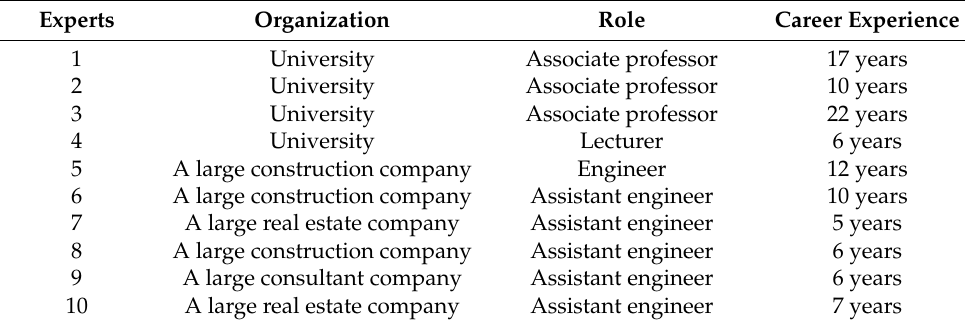
Table A1. Detailed profiles of the experts.